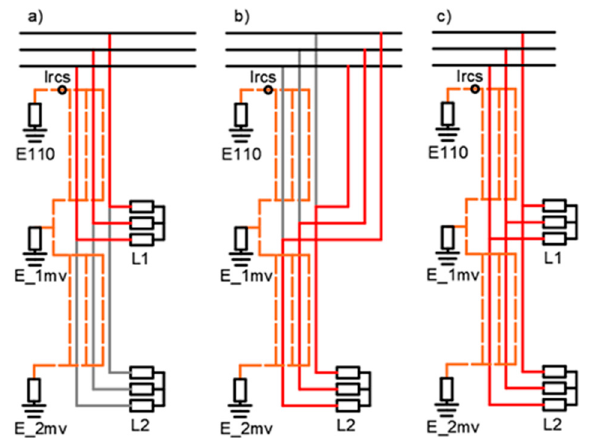
Figure 9. Residual currents of cable segments— I r cs —in case of loads load A in section cc1 and B in